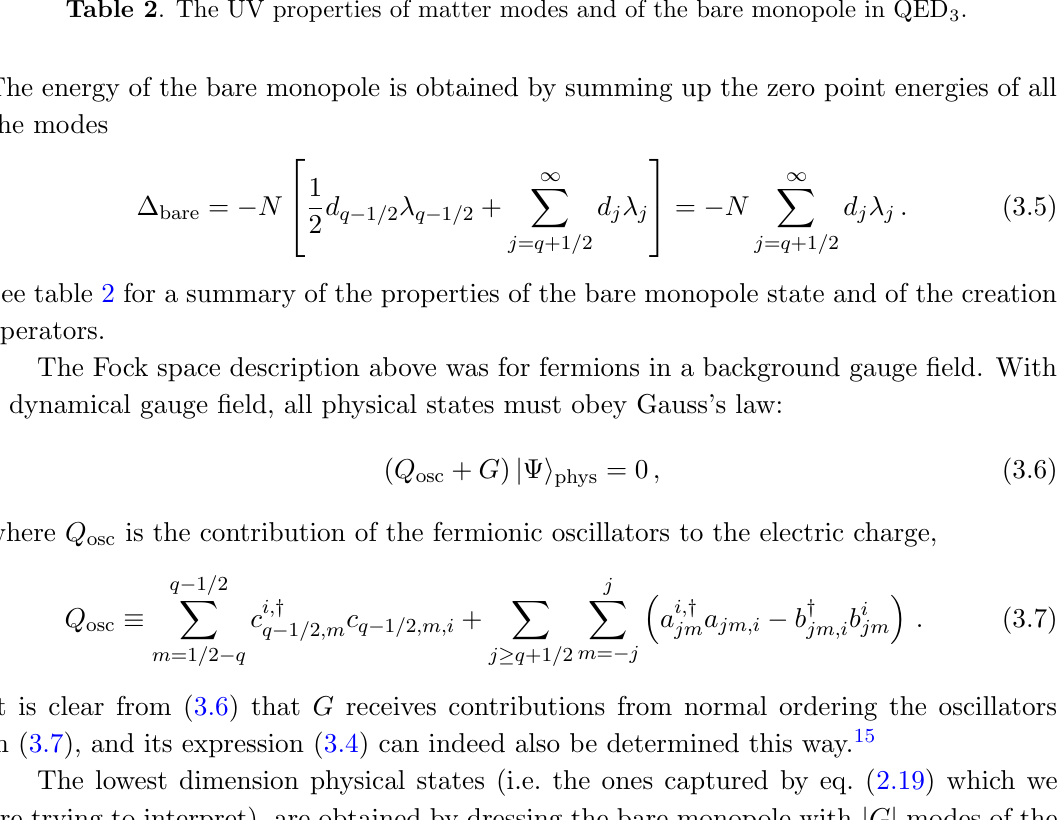
Table 2 . The UV properties of matter modes and of the bare monopole in QED 3